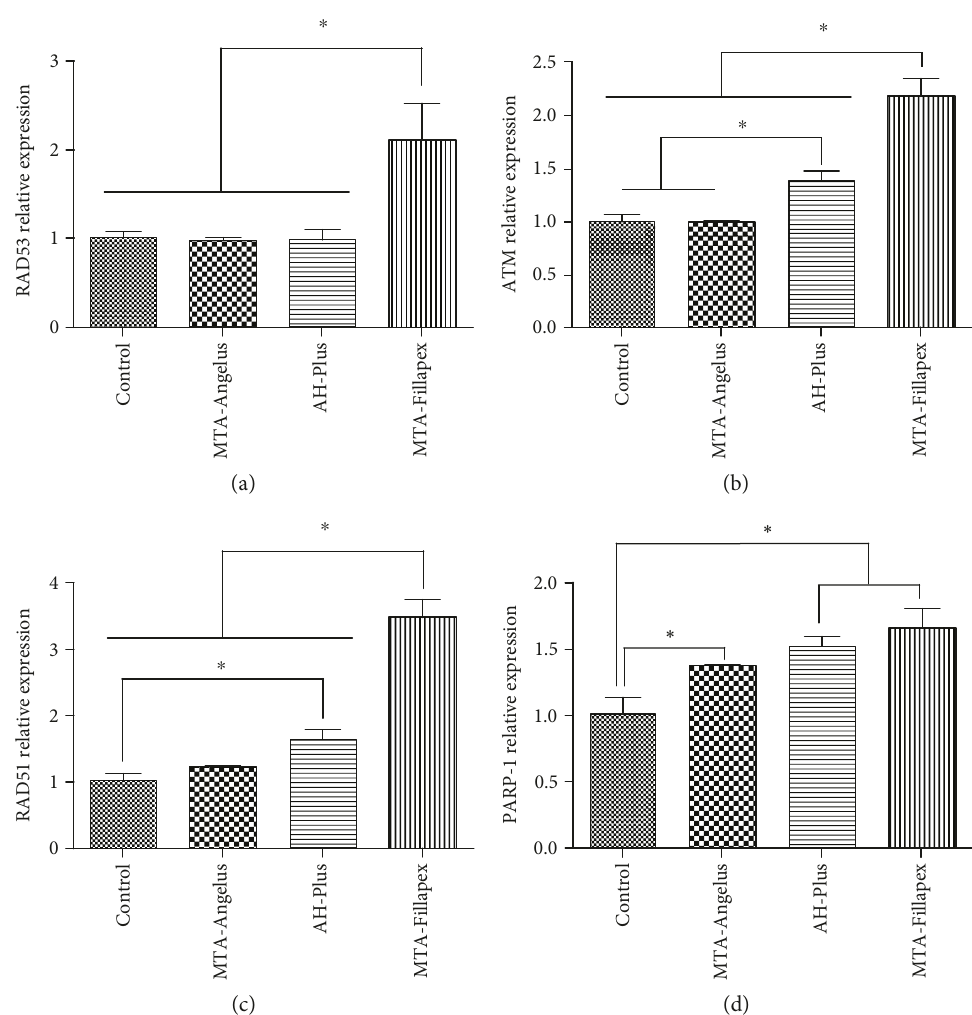
Figure 4: Analysis of expression of DNA damage responses and repair genes in HDPSCs incubated with endodontic materials at 48hours, by the technique of real-time polymerase chain reaction (qRT-PCR) for (a) RAD53, (b) ATM, (c) RAD51, and (d) PARP-1. The statistical test used was ANOVA with a post hoc Newman-Keuls test to analyze changes in the relative expression of DNA damage response and DNA repair genes. ∗ indicates signi fi cant di ff erences between groups compared ( p < 0 05 ). Each sample was analyzed in